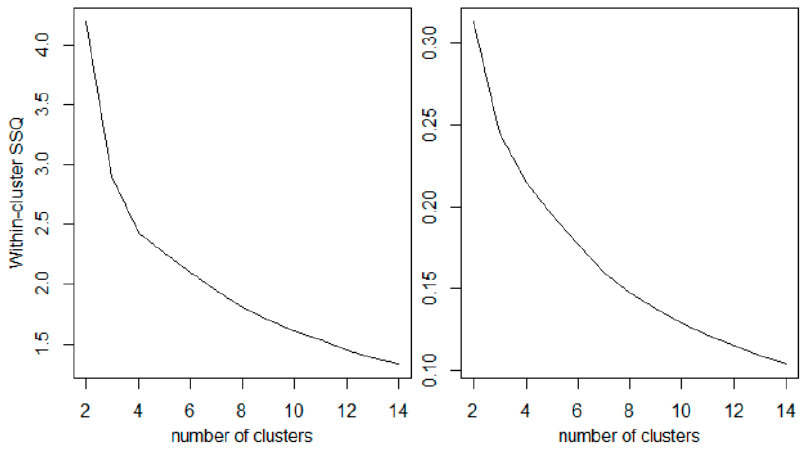
Figure 4. Scree plots of the within-cluster sums of squares for the unweighted ( left ) and weighted ( right ) classifications.